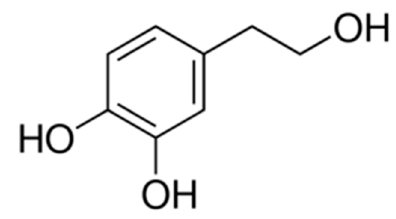
Figure 1. Chemical structure of hydroxytyrosol (HT).